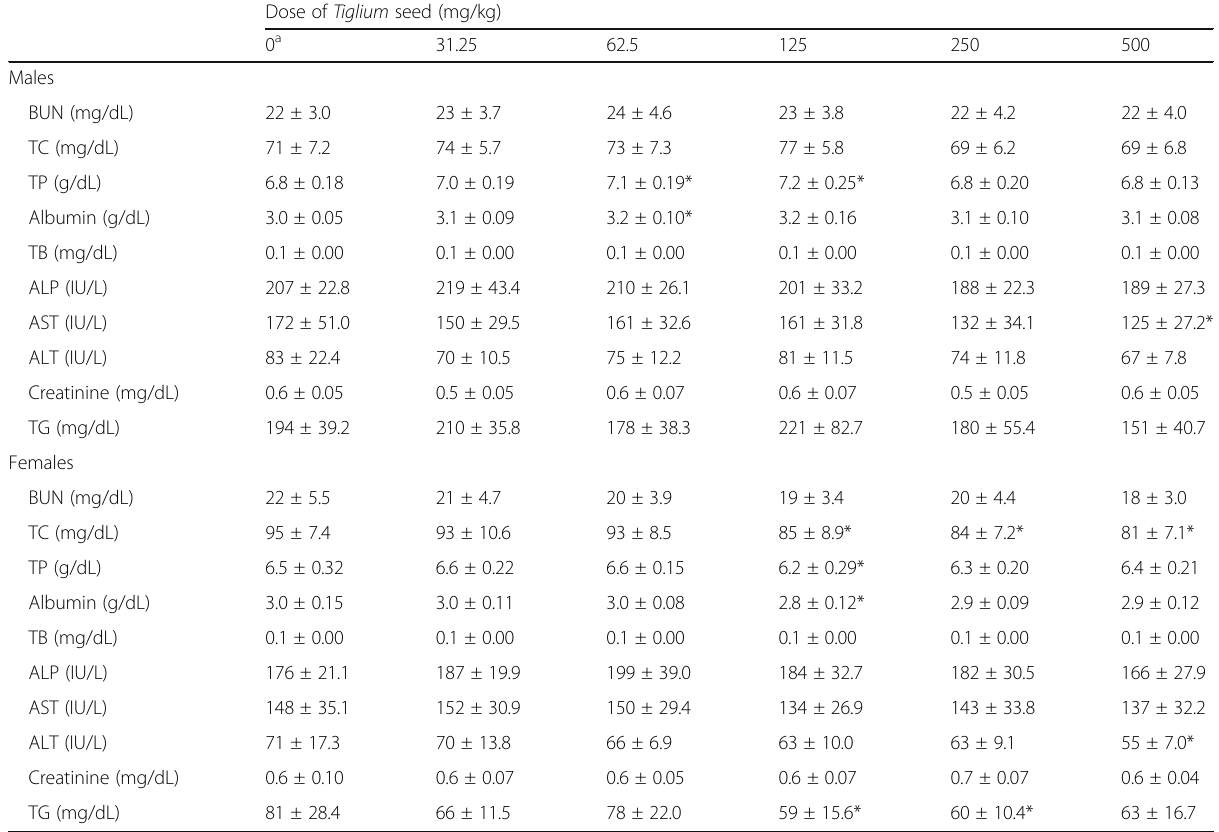
Table 2 Serum biochemistry data of male and female F344 rats orally administered with Tiglium seed extract for 13